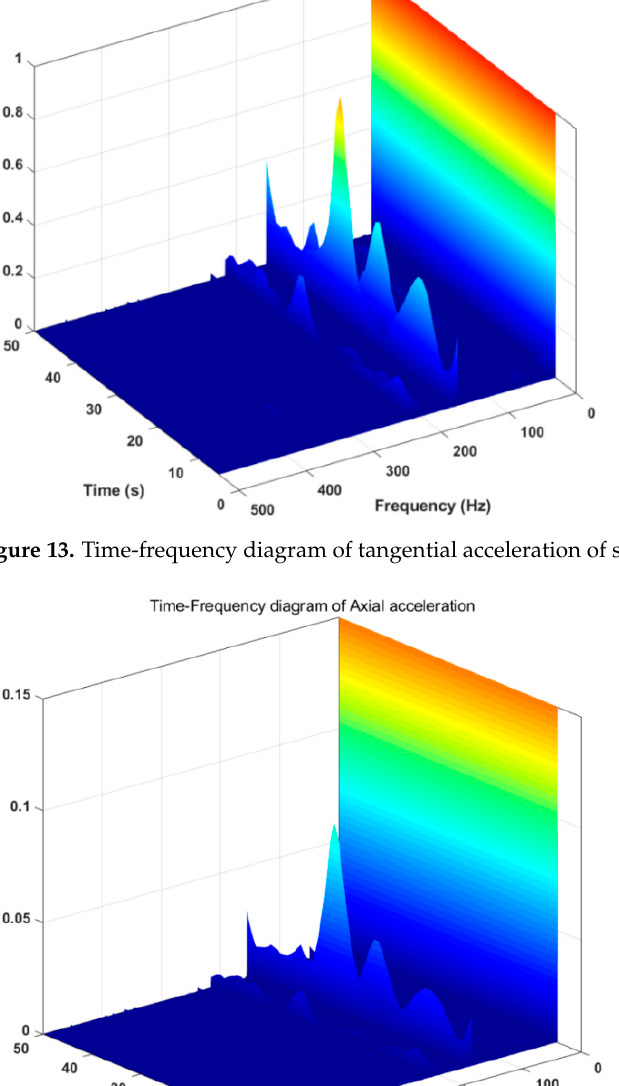
Figure 12. Radial time ‐ frequency diagram of stick ‐ slip vibration using light and shade to indicate the value of energy spectrum density.